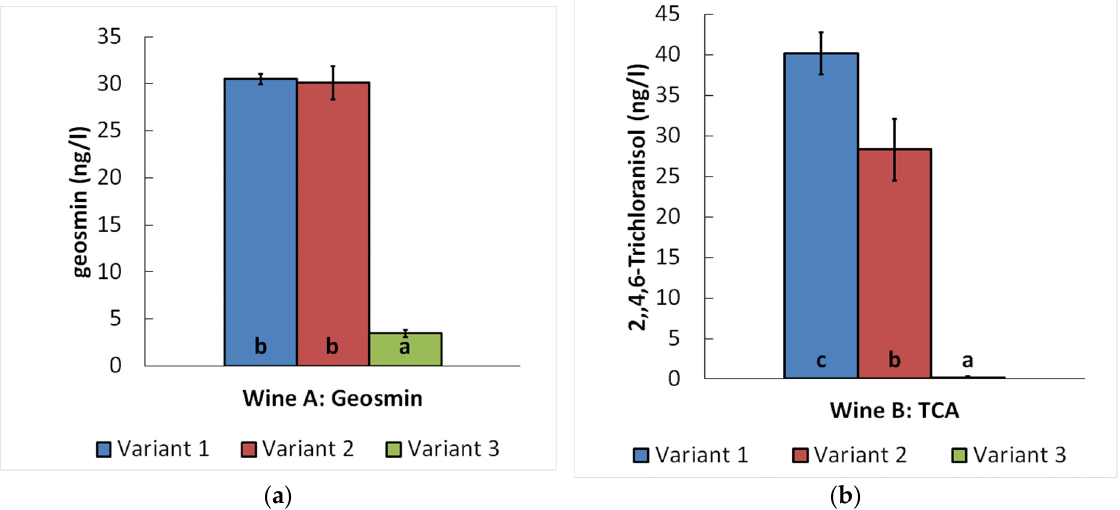
Figure 1. Reduction in impact substances of wine defects by filtration with conventional EKS layers (variant 2) and Fibrafix ® TX layers (variant 3) compared with the control sample (variant 1) in the small-scale test: ( a ) geosmin; ( b ) 2,4,6-trichloroanisole. Significance test by simple ANOVA and post hoc test Tukey B test. Same letters mean no significant difference based on significance level p ≤ 0.05 with alphabetical order, starting with a (smallest value) to c (largest value).